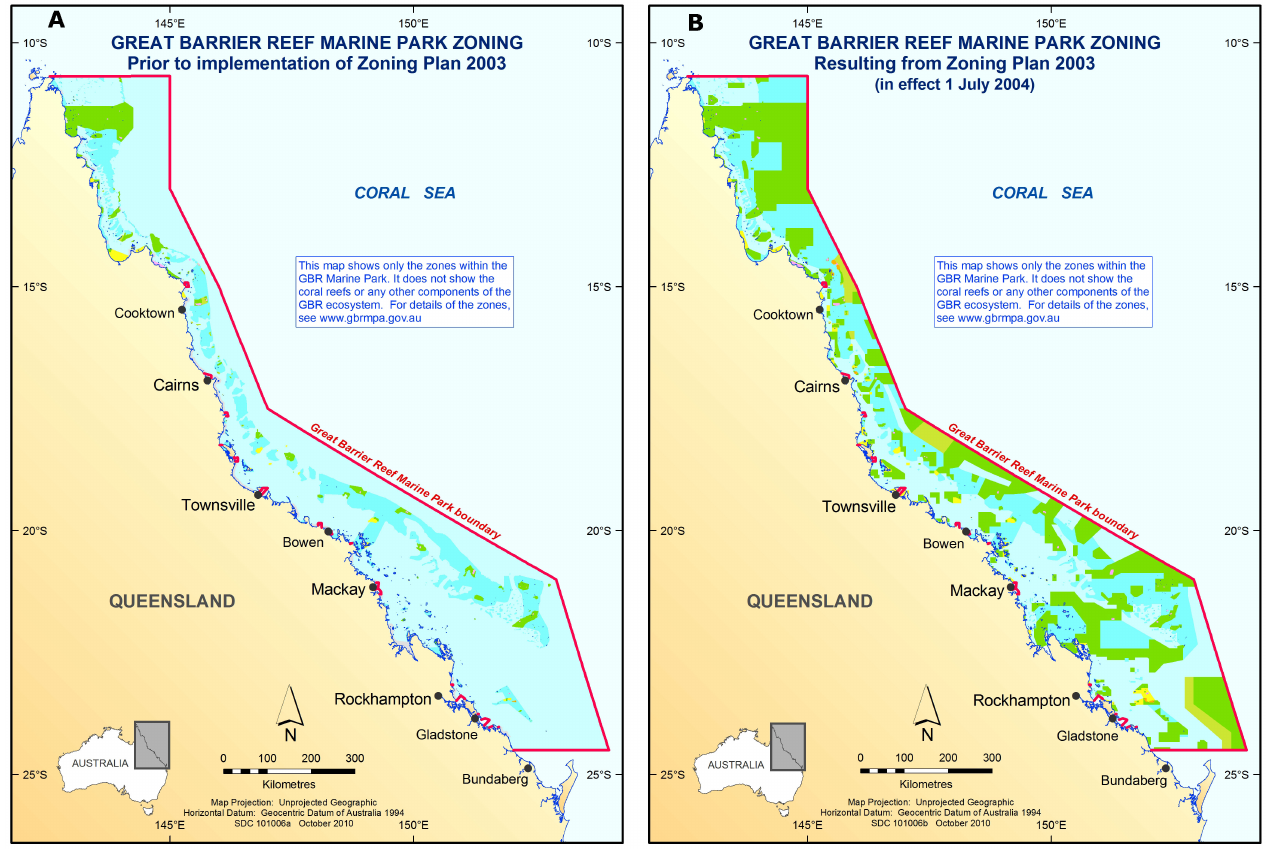
Fig. 1. Great Barrier Reef Marine Park before (A) and after (B) rezoning. Green, Marine National Park Zone (also called Green Zone; these are no-take zones); light blue, General Use Zone; turquoise, Habitat Protection Zone; yellow, Conservation Park Zone; olive, Buffer Zone; orange, Scientific Research Zone; red, Preservation Zone. Maps courtesy of the Spatial Data Centre, Great Barrier Reef Marine Park Authority, © Commonwealth of Australia (Great Barrier Reef Marine Park Authority)